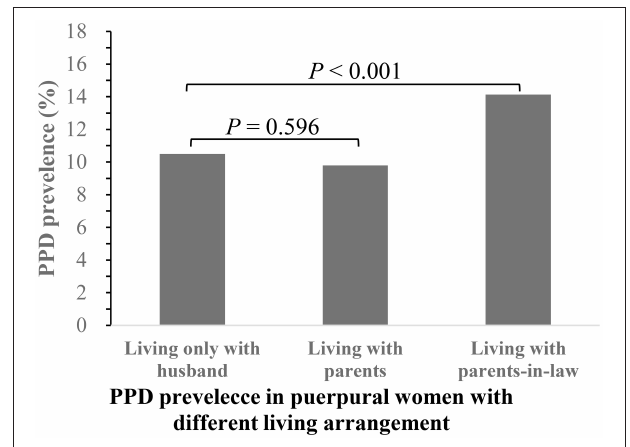
FIGURE 1 | The PPD prevalence in puerpural women with different living